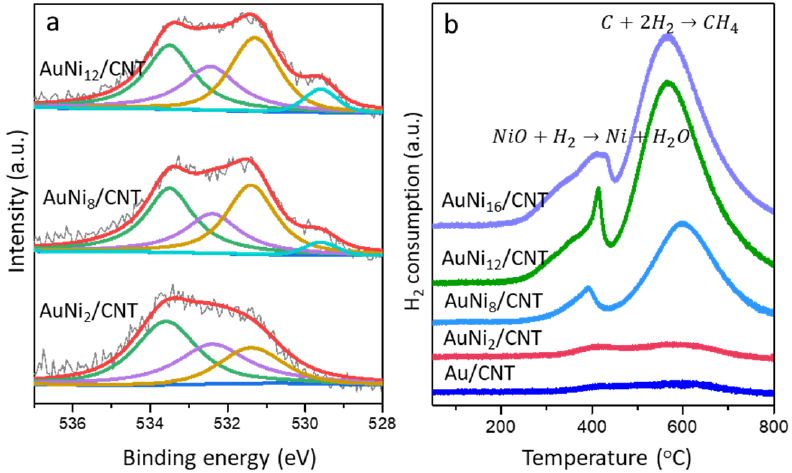
Figure 7. XPS spectra of the O 1 s core level ( a ) and H 2 -TPR profiles ( b ) of different AuNi x /CNT samples.